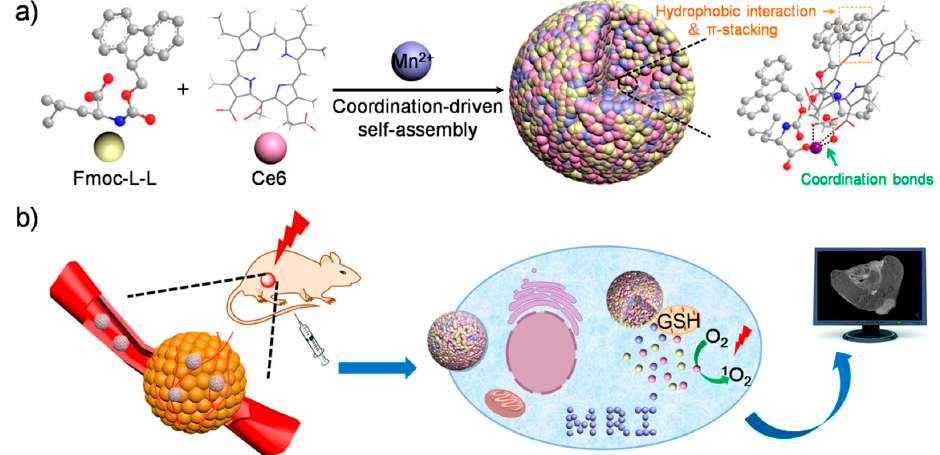
Figure 11. Fmoc L-L coordinated to photosensitizer chlorin e6 nanoplatform for enhanced cellular uptake and tumor accumu-lation in addition to the tumor microenvironment (GSH)-responsive release of drugs for photodynamic therapy PDT and mag-netic resonance imaging agents. ( a ) Synthesis steps of the peptidic nanoplatform with PDT photosensitizer and Mn 2+ for MRI. ( b ) In vivo PDT with imaging MRI monitoring showing a superior antitumor efficacy and MR and optical imaging capability. A complete tumor eradication after PDT was observed showing their potential as a bio- compatible and efficient phototherapy agent. Re-printed with permission from reference [166].